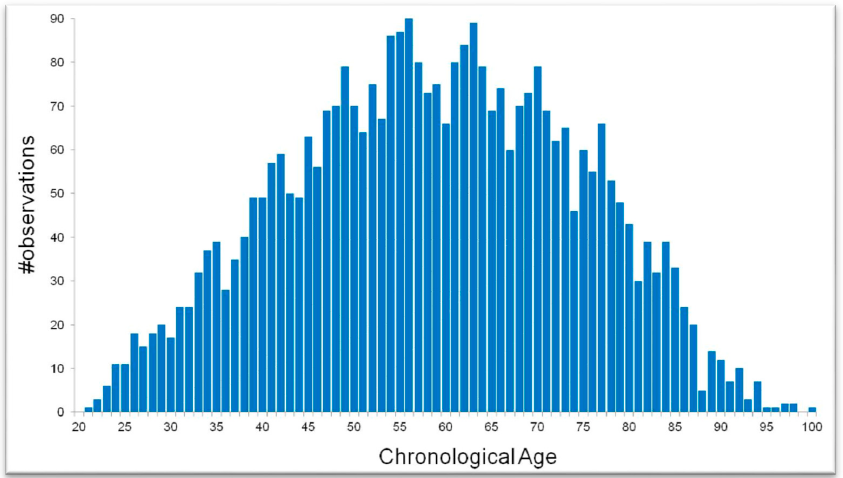
Figure 1. Frequency of longitudinal observations over age. The models included 3468 data points from 582